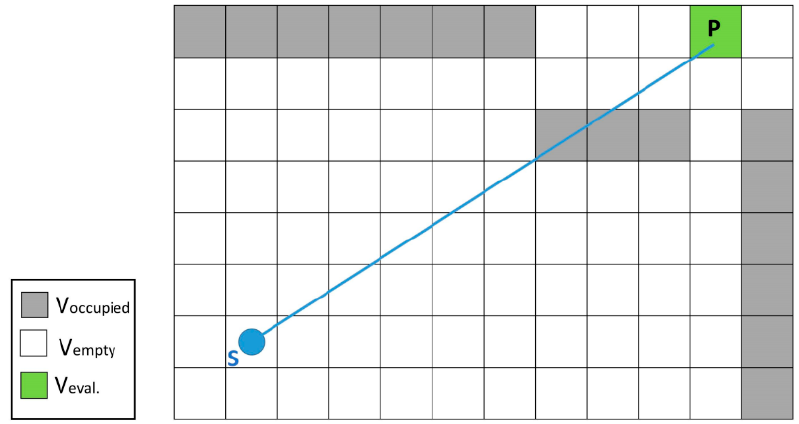
Figure 7. Ray-tracing labelling principle: point P is marked as occluded because the ray connecting it to the scanner position S traverses a voxel that is defined as occupied.